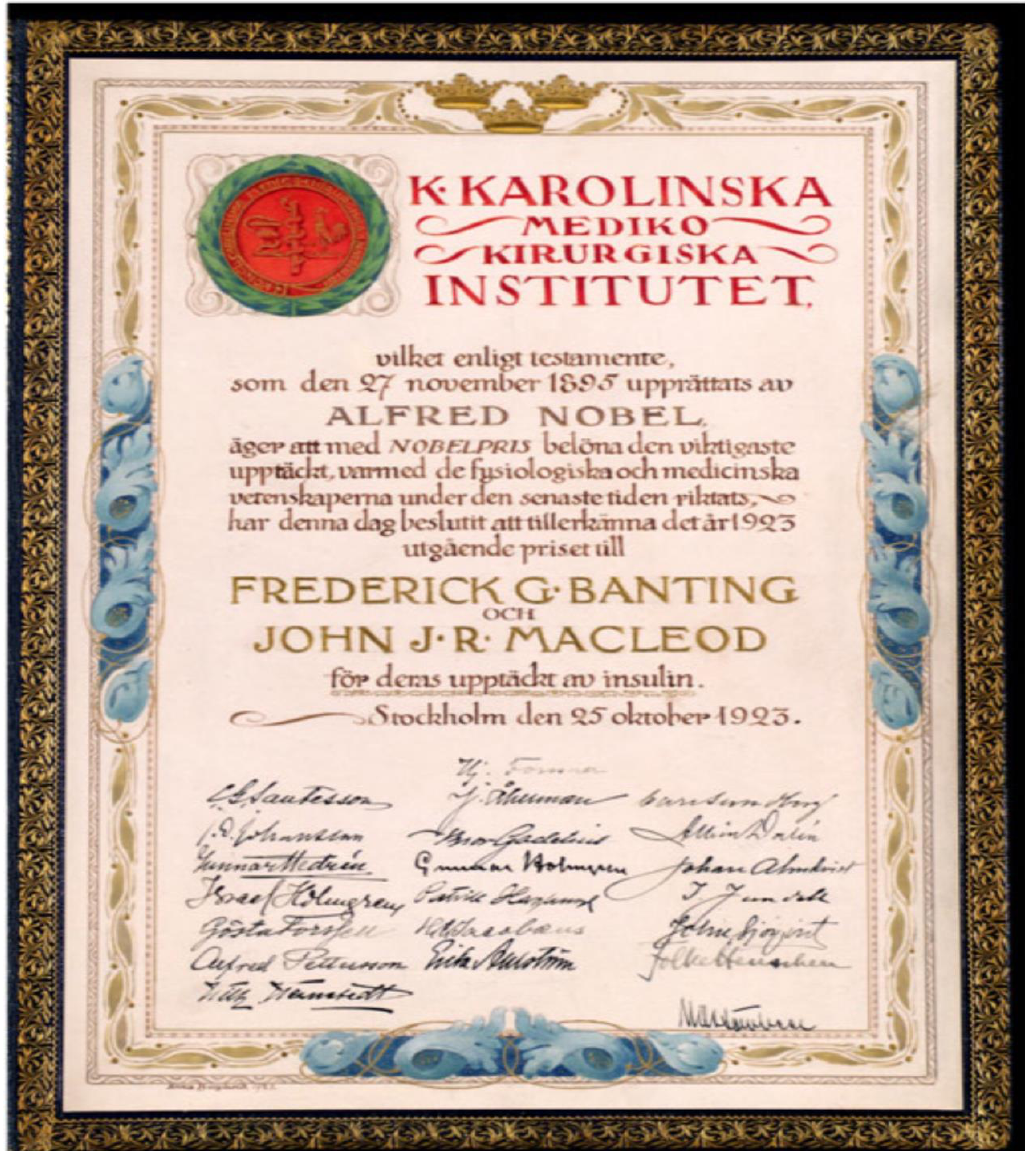
Figure 1. The Nobel Prize certificate to Banting and Macleod signed by the 21 members of the Nobel Prize committee. From the Nobel Foundation. In his 1925 Nobel Lecture, Macleod closed by raising the question—what is the mechanism of insulin action in the body?